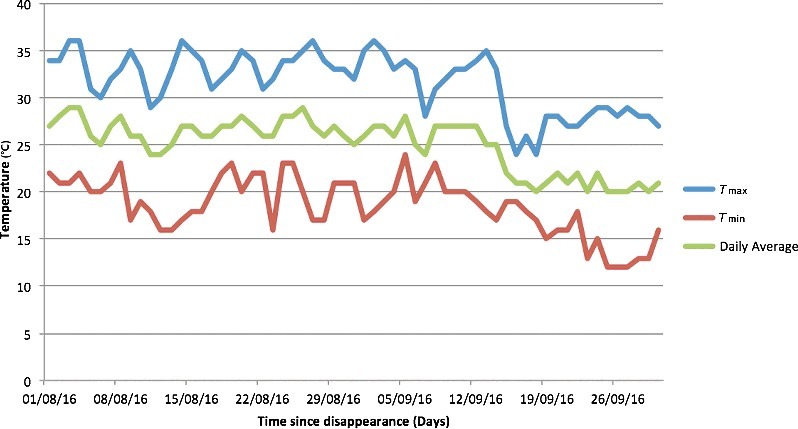
Temperatures recorded by the weather station (5.1 km far from the death scene) for the 34 days before the discovery of the body (Tmax: 30.0 °C; Tmin: 12.0 °C) in Case 2.